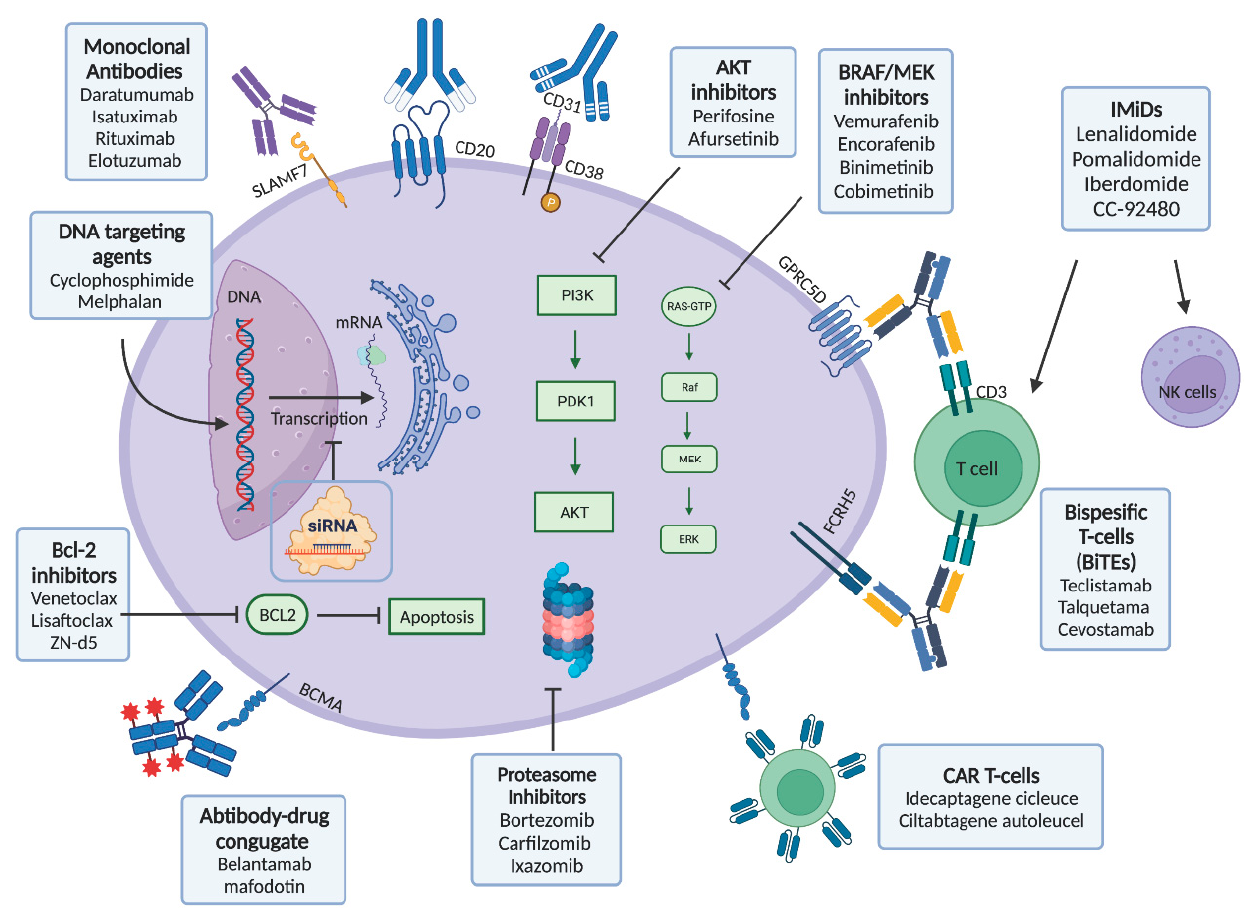
Figure 1. Actionable cellular molecules and signaling pathways to target plasma cells in AL amy- loidosis. Created with BioRender.com (accessed on 3 January 2022).